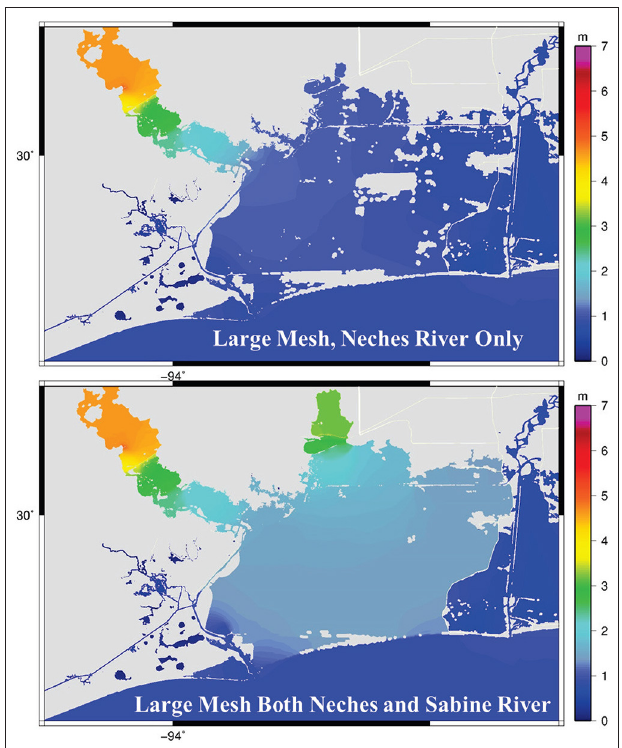
FIGURE 7 | Maximum elevation in the computational elements over the period of simulation for the large ADCIRC mesh with only Neches River and both Neches and Sabine River flows. These plots are not representative of any singular point in time, but instead, the maximum elevation reached at each point in space over the course of the whole